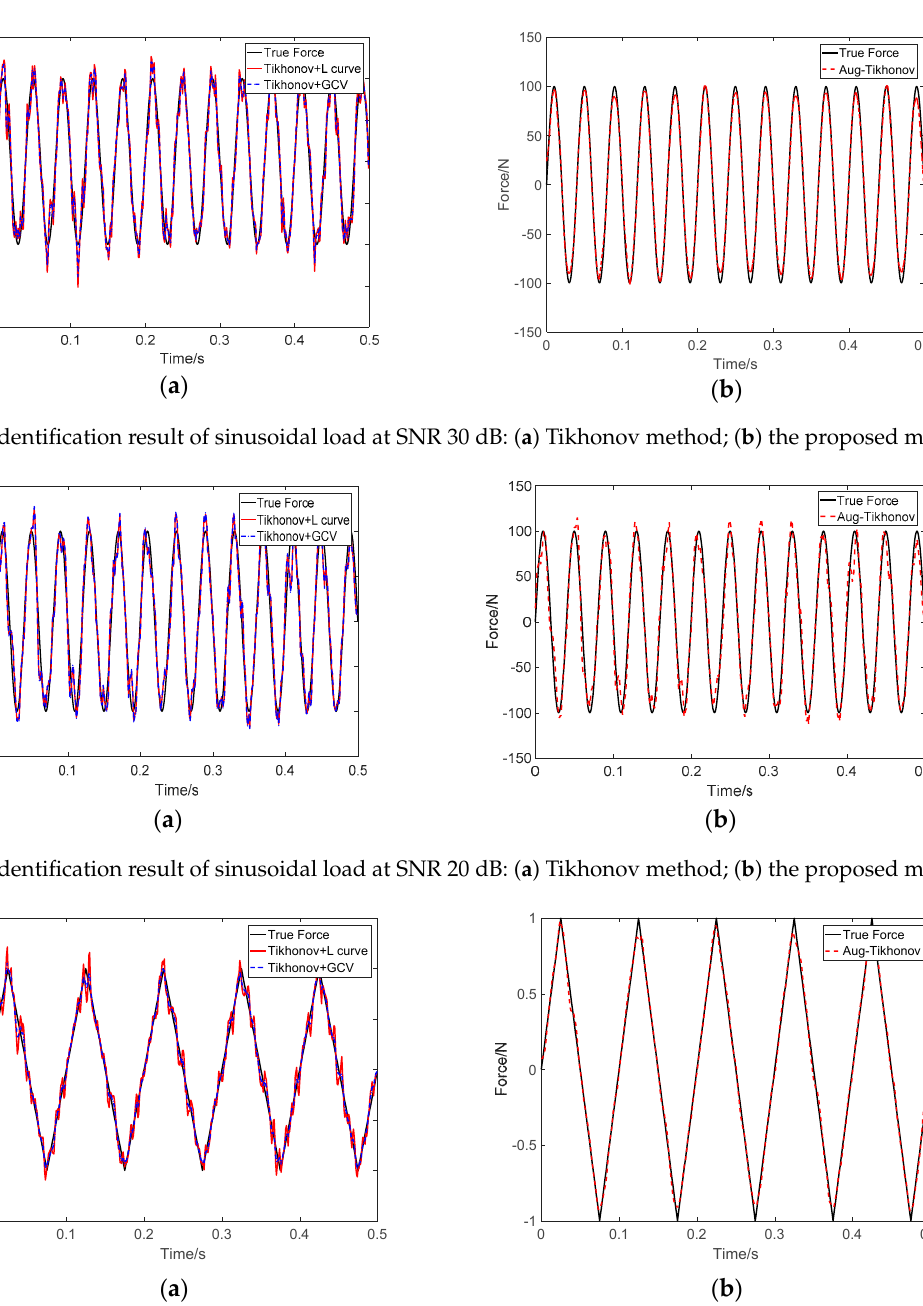
Figure 5. Identification result of sinusoidal load at SNR 40 dB: ( a ) Tikhonov method; ( b ) the proposed method.